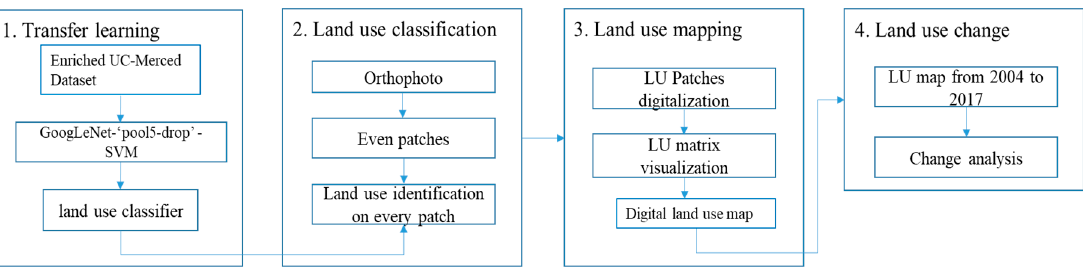
Figure 5. Study area—north-east section of the Cloverdale, community of the City of Surrey, Canada [49,52].